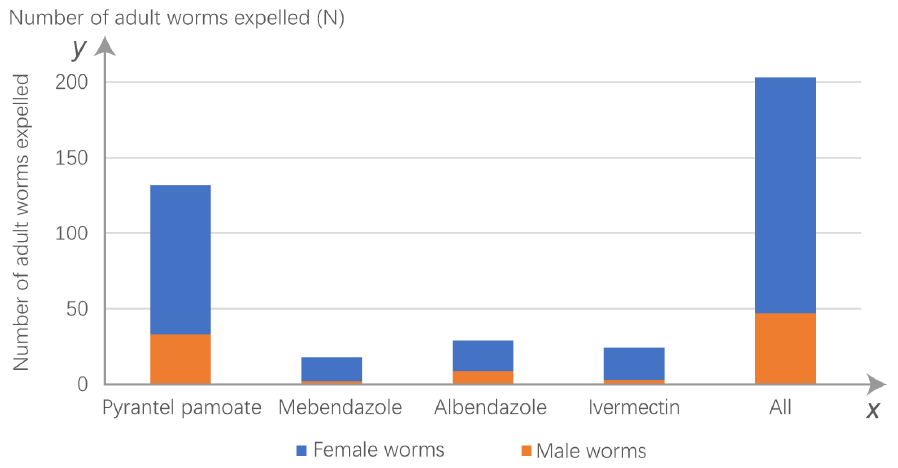
Figure 3. Sex ratio of expelled worms.